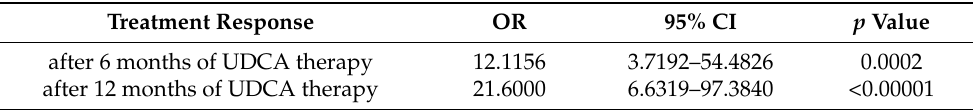
Table 6. Association of response to UDCA treatment in PBC patients and the history of liver decompensation (simple logistic regression).